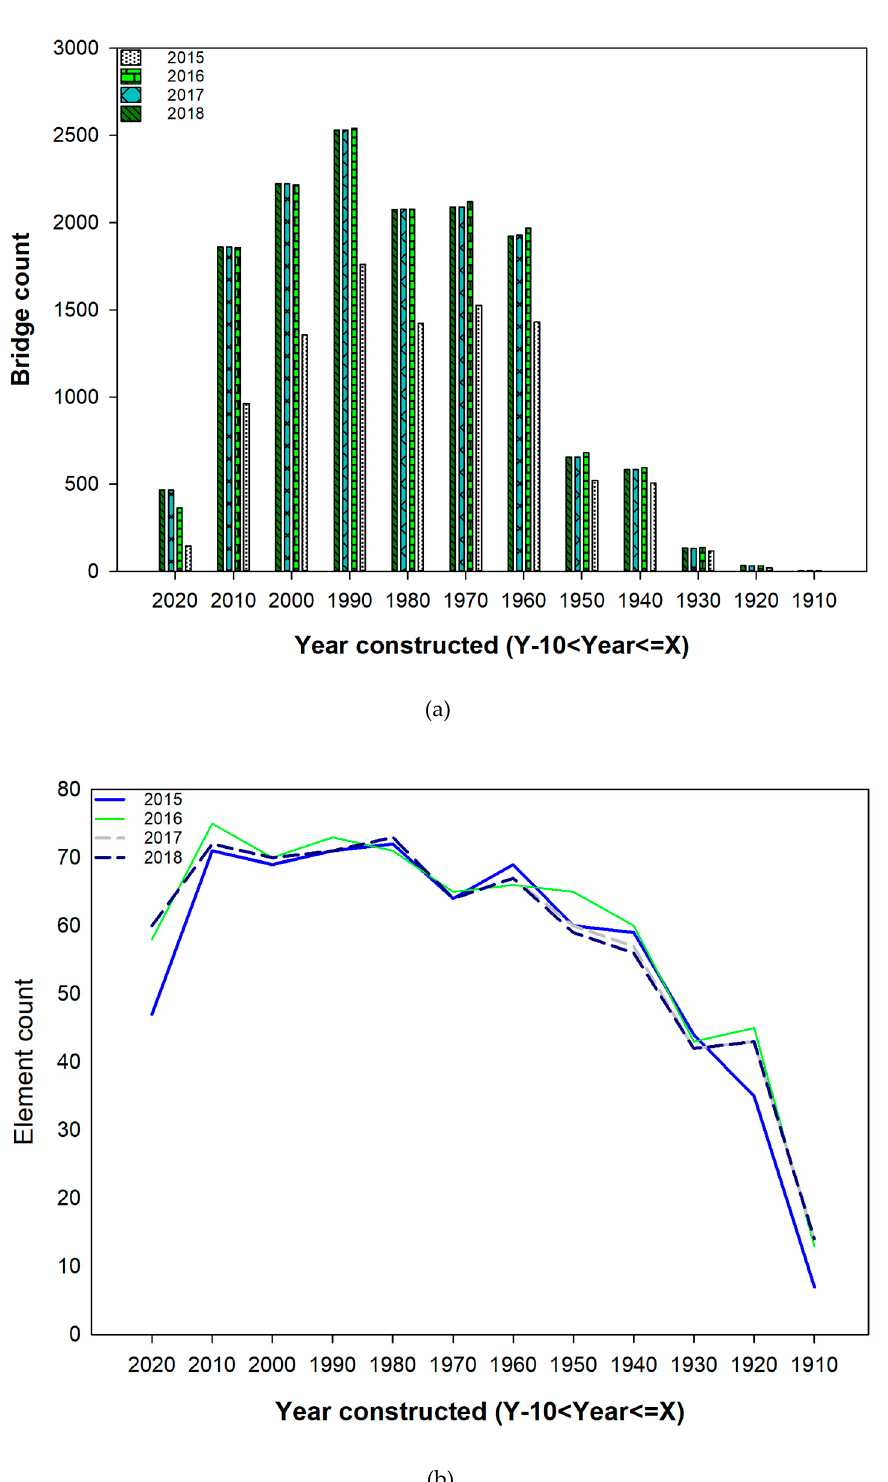
Figure 1. Bridge and element counts in the Georgia (GA) bridge inventory. ( a ) The number of bridges constructed in 12 age bins. ( b ) The number of elements in a bridge by year constructed.